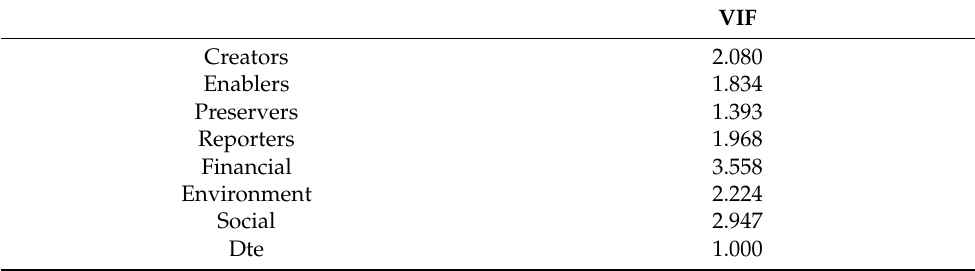
Table 8. Multicollinearity of endogenous variables.